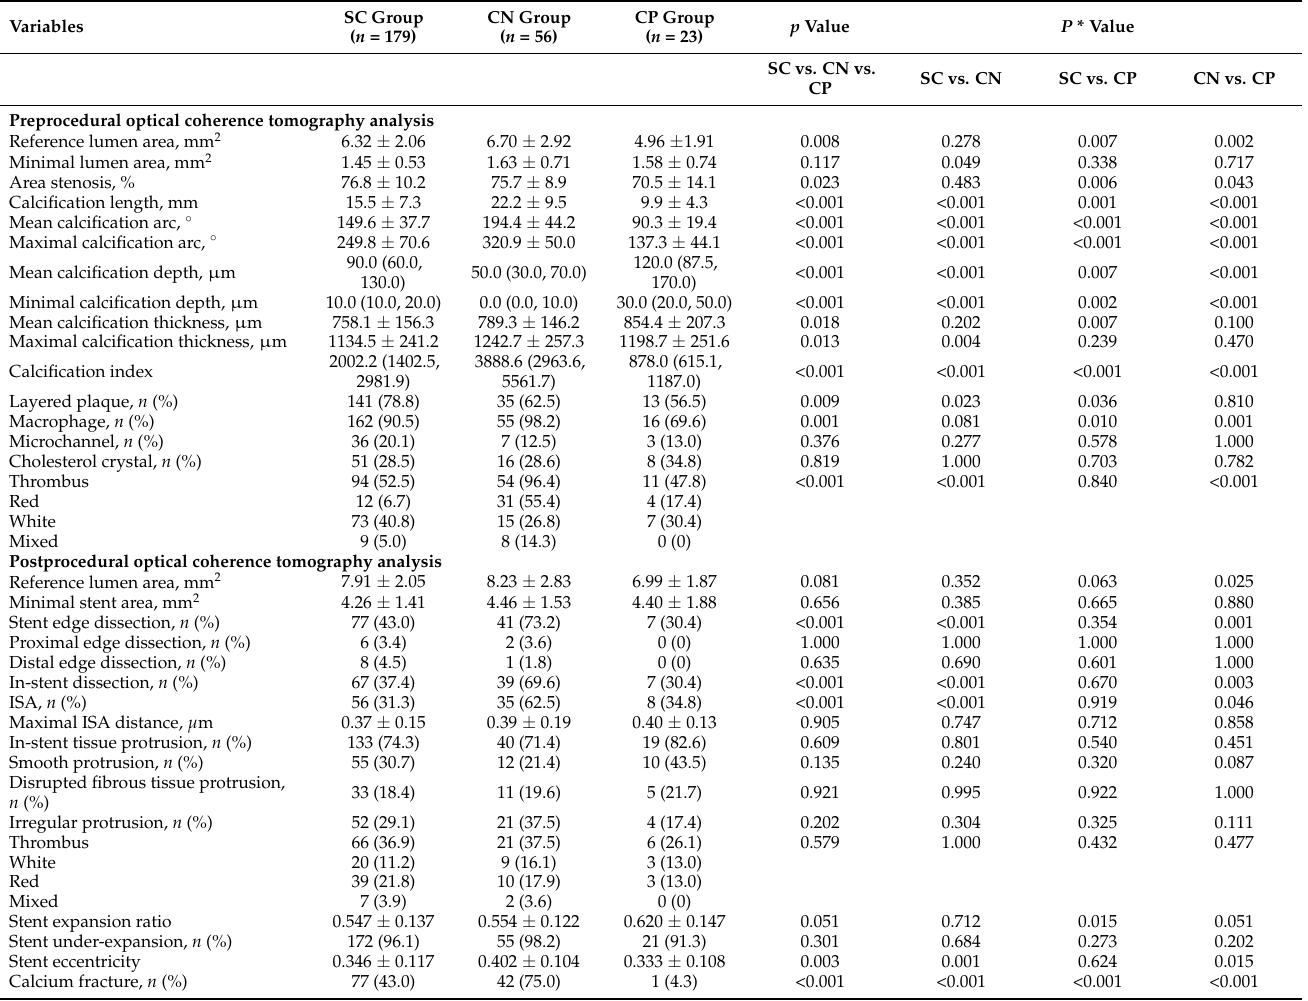
Table 3. Optical coherence tomography analysis of different calcified culprit